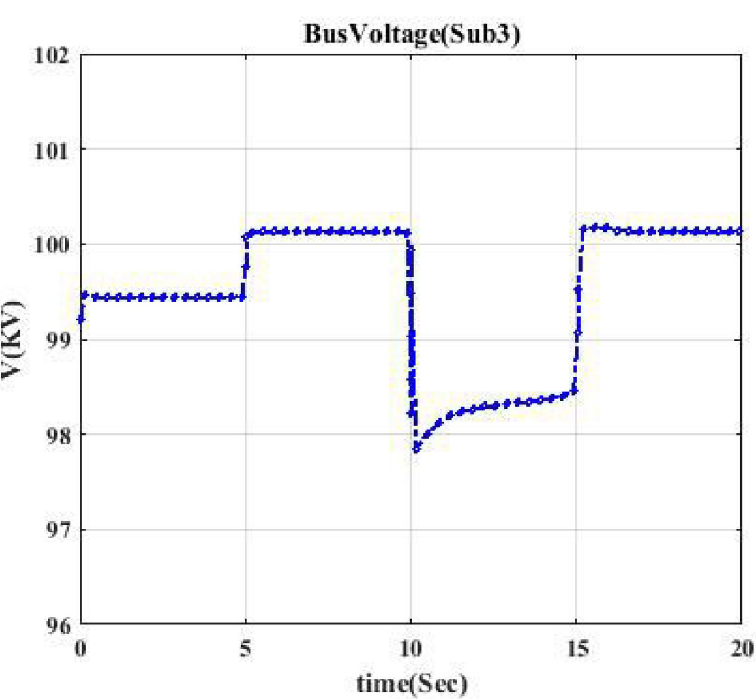
Fig 5. Voltage profile related to switching Sub3-S2. This shows the voltage curve when switch S2 is switched.